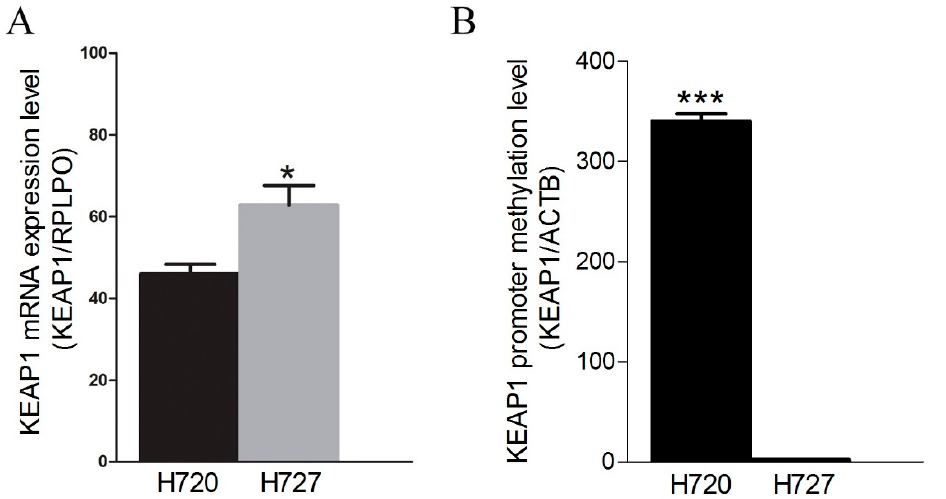
Figure 2. ( A ) Expression level analysis (± standard error mean) of the KEAP1 gene in H720 and H727 determined by RT-qPCR. The relative quantification was expressed as the ratio marker ( B ) Methylation levels ( ± standard error mean) of KEAP1 in H720 and H727 determined by qMSP (KEAP1/RPLPO). ( B ) Methylation levels (± standard error mean) of KEAP1 in H720 and H727 ( N = 4). * p < 0.05, *** p < 0.0001 t -test. determined by qMSP ( N = 4). * p < 0.05, *** p < 0.0001 t -test.